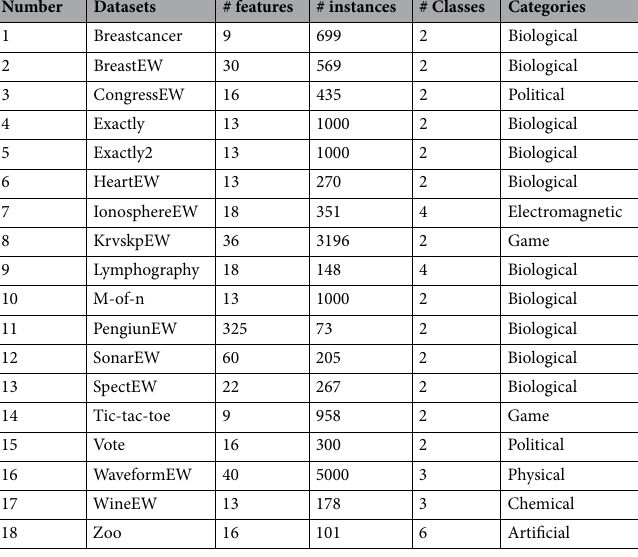
Table 1. Datasets and their